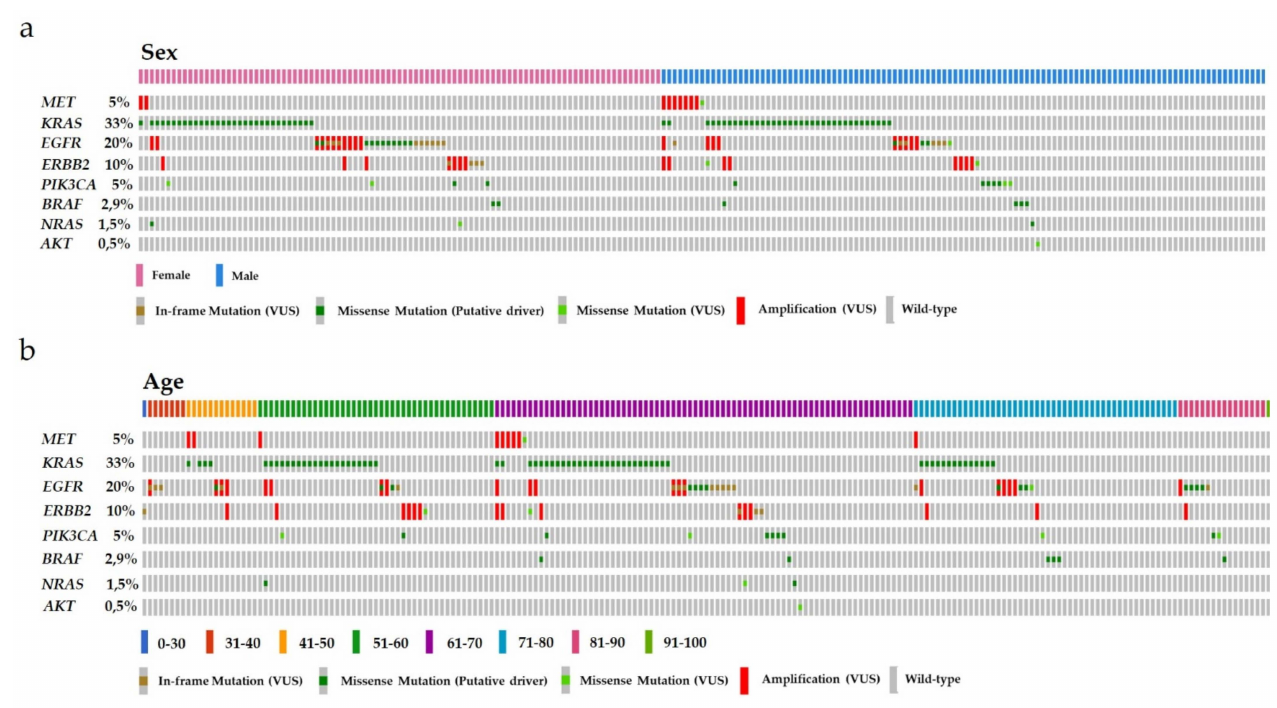
Figure 3. Mutational profile of the consecutive NSCLC cohort regarding the sex and age of the patients. ( a ) Arrangement of the cases according to the sex of the patients. Each column represents one case. Pink color resembles females, whereas the blue color resembles males. ( b ) Arrangement of the cases according to the age of the patients. Each column represents one case. The various age groups are colored differently (dark blue = 0–30, red = 31–40, orange = 41–50, dark green = 51–60, violet = 61–70, light blue = 71–80, pink = 81–90, light green = 91–100). In both ( a , b ) the affected genes are listed on the left with the frequency in the cohort shown as percent. Furthermore, in both ( a , b ), in-frame or missense mutations classified as variants of unknown significance (VUS) are labeled in brown and light green, respectively. Known missense mutations (putative driver mutations) are labeled in dark green. Cases harboring an alteration in gene copy numbers are depicted in red. Nonmutant, wild type samples are labeled in